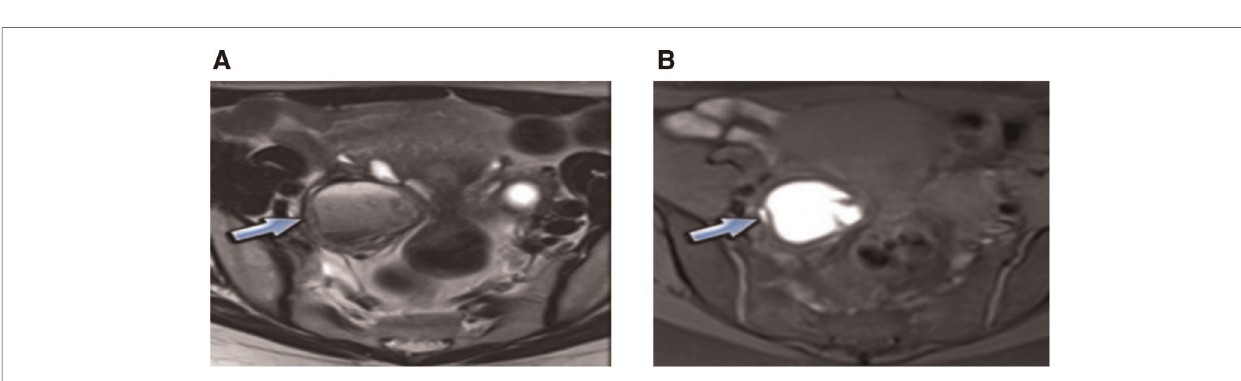
FIGURE 3 | Ovary involvement: ( A ) T2w: “ shading effect, ” ( B ) T1w: